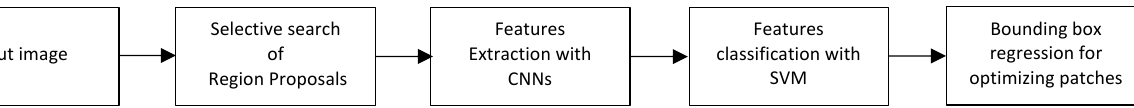
Figure 5. Flowchart of the R-CNN model (Adapted from ref. [4]).